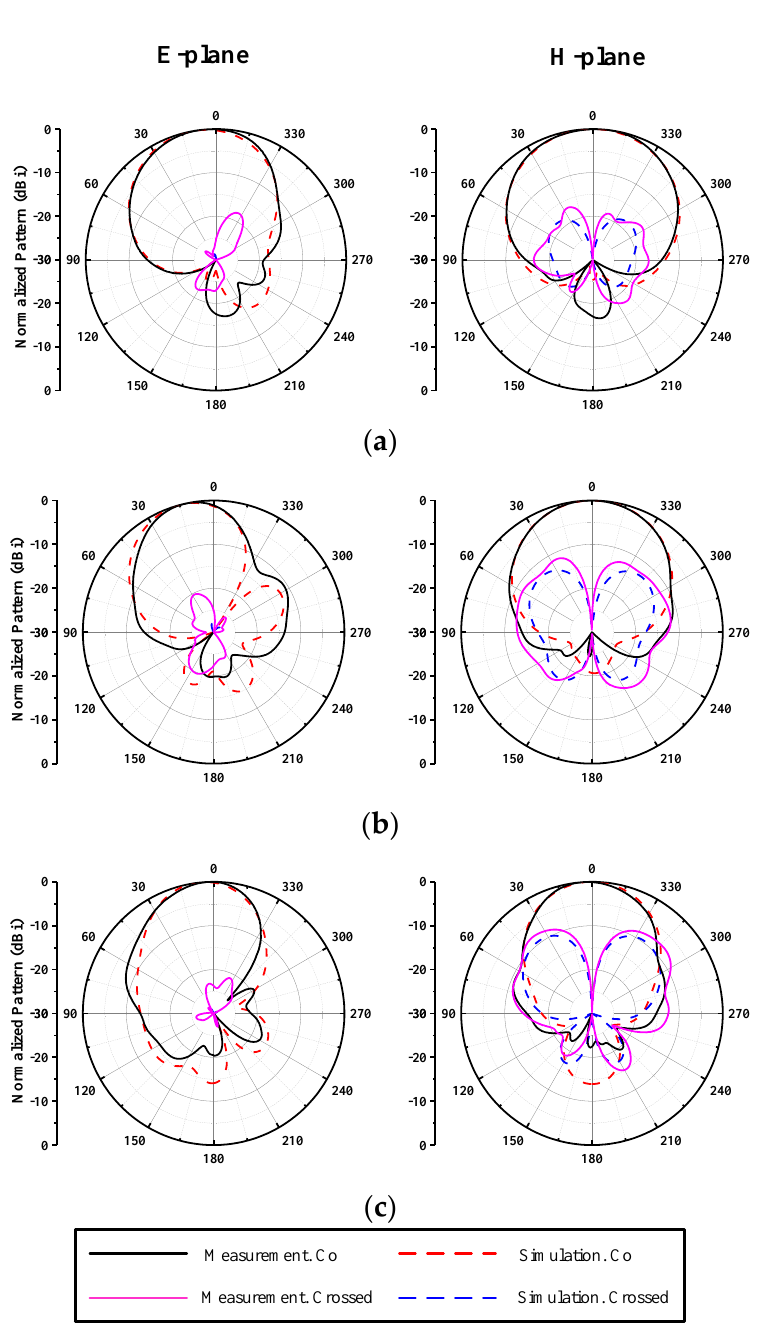
Measurement. Co Simulation. Co Measurement. Crossed Simulation. Crossed Figure 11. The simulated and measured radiation patterns at ( a ) 1.4 GHz, ( b ) 1.8 GHz, ( c ) 2.2 GHz. Finally, a performance comparison between the proposed ME dipole and other pub- lished ME dipoles is listed in Table 2. For reference [10], which is the classical ME dipole antenna, the profile is up to 0.25 λ 0 together with an average gain of 8 dBi. With the de- velopment of different low-profile techniques, the profile can be reduced to 0.097 λ 0 in reference [15]. However, the relative bandwidth is only 28.2%. In reference [17], the relative bandwidth is up to 54.8%, while the profile is only 0.173 λ 0 . In reference [19], the antenna has a profile of 0.11 λ 0 , but the bandwidth is only 27.6%. Among these ME dipole antennas in Table 2, the one proposed in this work is a competitive candidate in low-profile and wideband applications due to the thickness of 0.095 λ 0 and relative bandwidth of